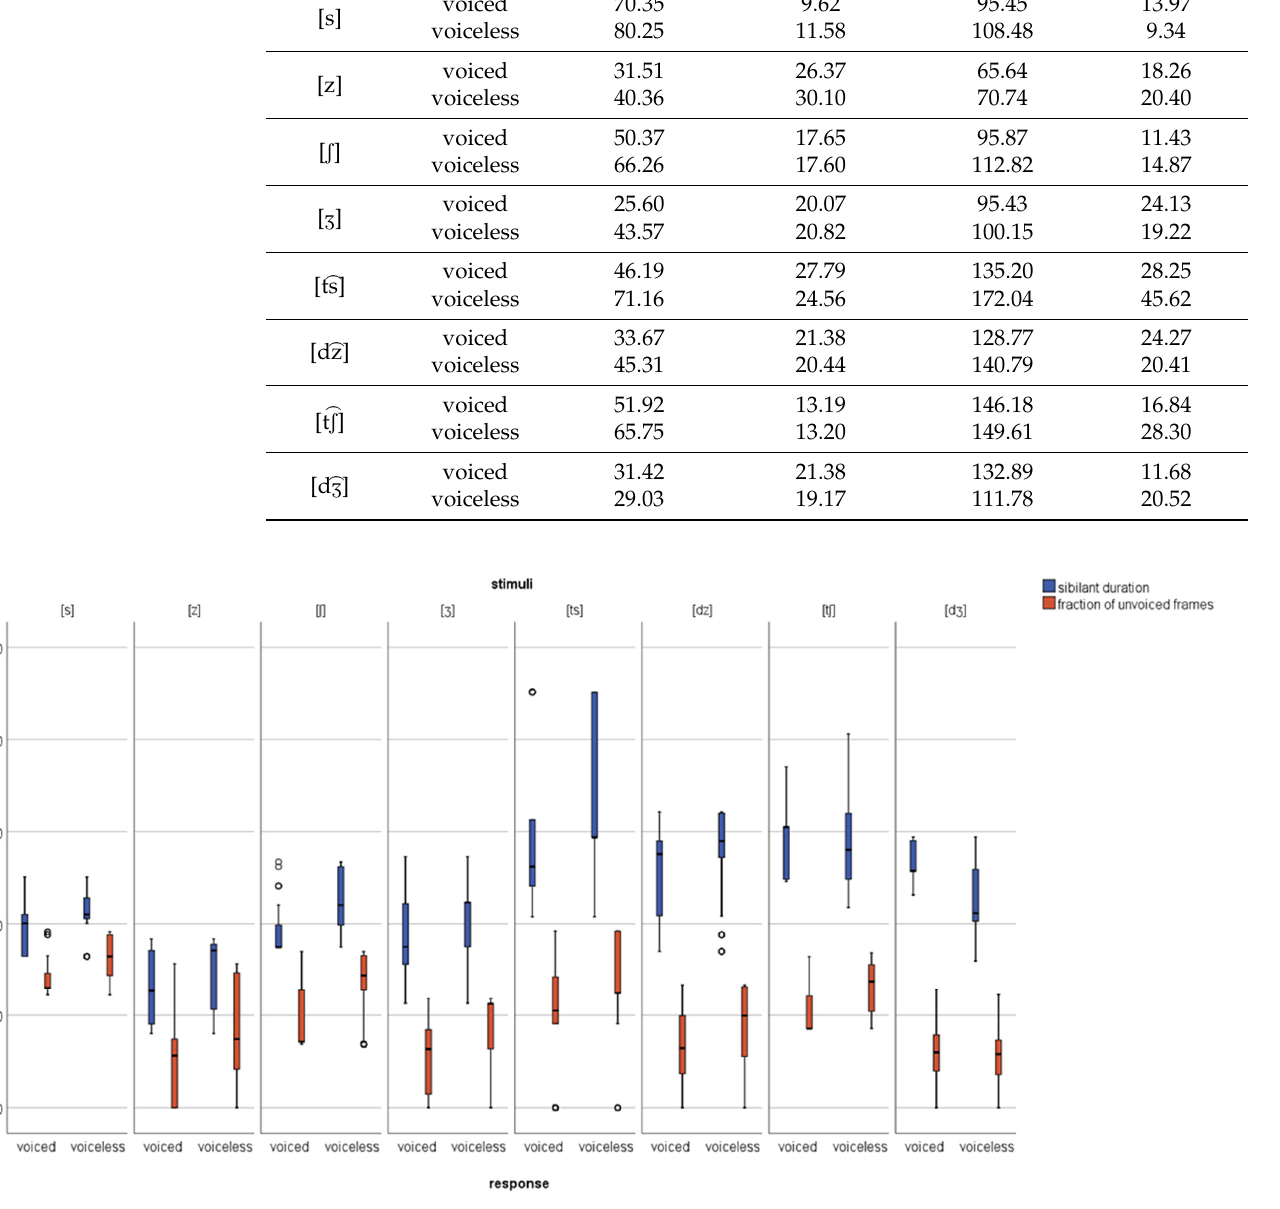
Figure 4. Box plots representing duration values (blue boxes) and fraction of unvoiced frames (orange boxes) in stimuli labelled as voiced and voiceless in each phonological category.